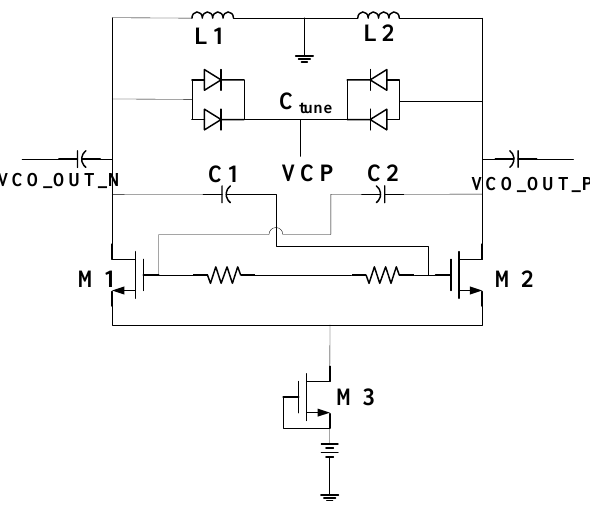
Figure 6. The structure of the VCO.